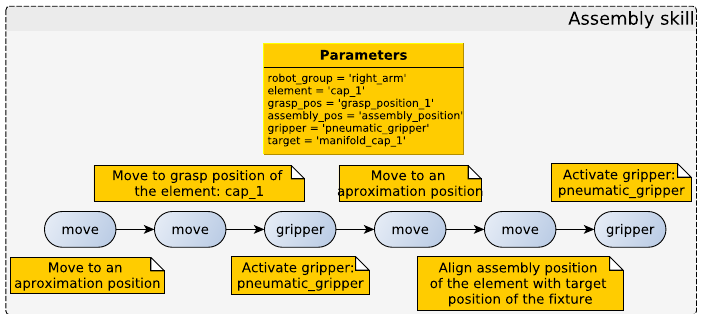
Figure 13. Assembly skill configuration for one cap of the